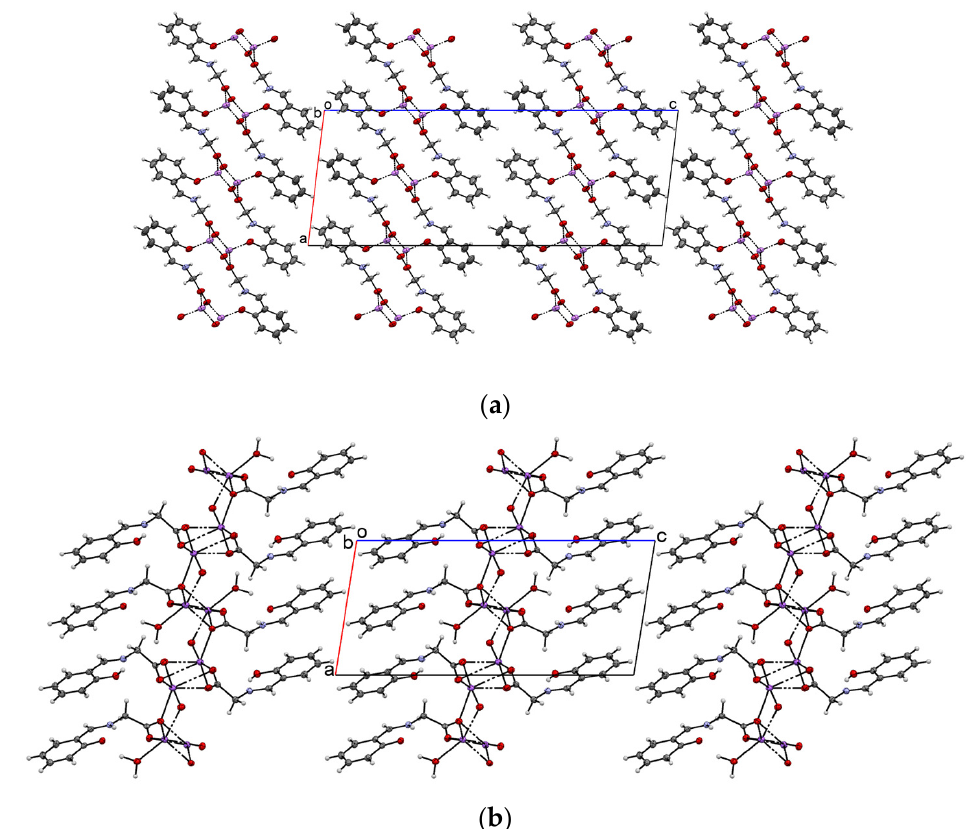
Figure 2. Crystal packing for ( a ) GlySalLi-a and ( b ) GlySalNa-h .